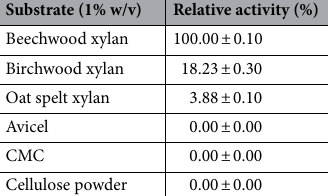
Substrate (1% w/v)